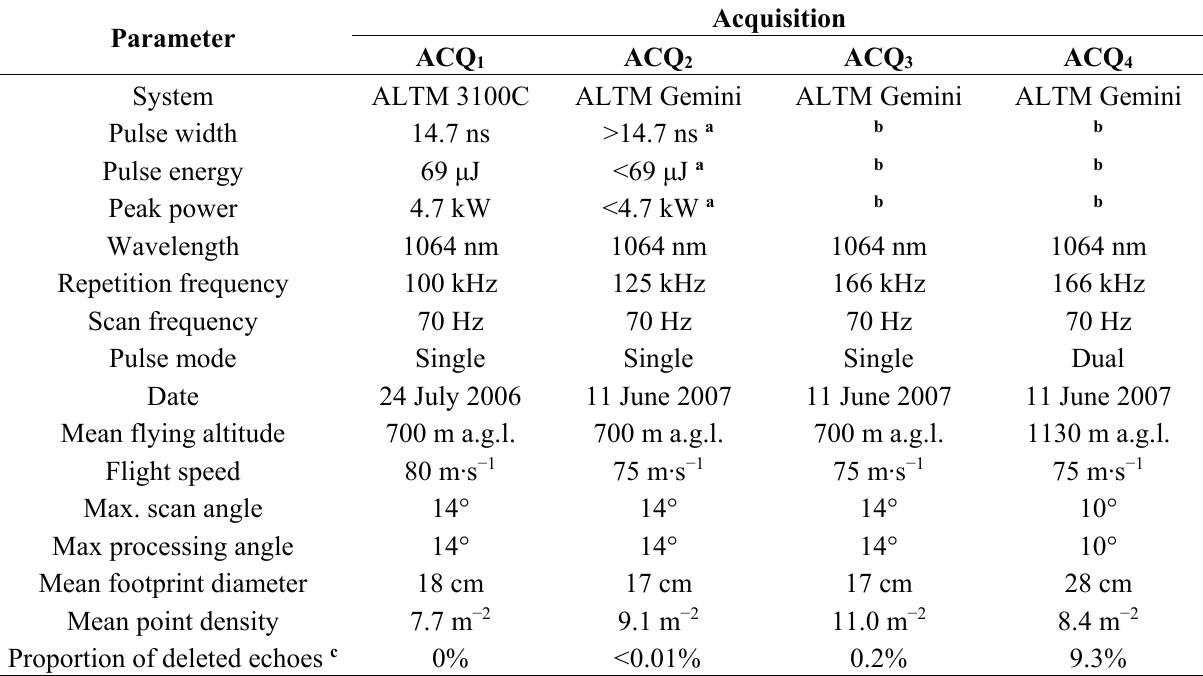
Table 2. Summary of laser scanner data and flight parameters of the four laser data